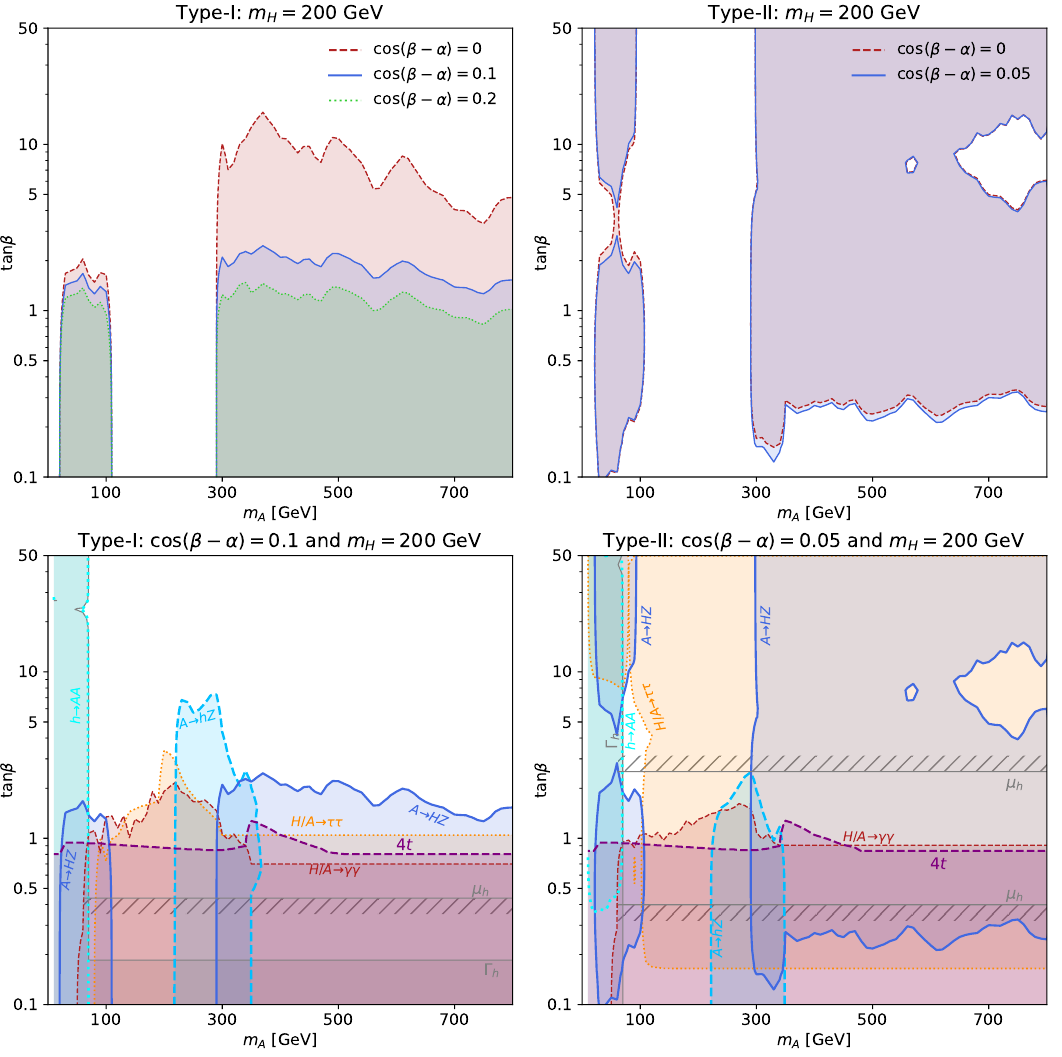
Figure 4 . Constraints on the Type-I (left panel) and the Type-II (right panel) 2HDM in m A (cid:0) t (cid:12) plane. Top: parameter space excluded at 95% C.L. by the A=H ! HZ=AZ search for m H = 200 GeV and c (cid:12) (cid:0) (cid:11) = 0 (red), 0 : 1 (blue) and 0 : 2 (green) in the left panel and c (cid:12) (cid:0) (cid:11) = 0 (red) and 0 : 05 (blue) in the right panel. Bottom: constraints at 95% C.L. for m H = 200 GeV and c (cid:12) (cid:0) (cid:11) = 0 : 1 from LHC searches for A ! HZ (blue), A ! hZ (dashed dark blue), H ! AA (dashed cyan), H=A ! (cid:28)(cid:28) (dotted orange), H=A ! (cid:13)(cid:13) (dashed brown) and 4 t production (dashed magenta) as well as the global (cid:12)t of SM-like Higgs couplings strength (cid:22) h (grey hatched region) and the Higgs width measurement (cid:0) h = 2 (0 : 08 ; 9 : 16) MeV (grey).